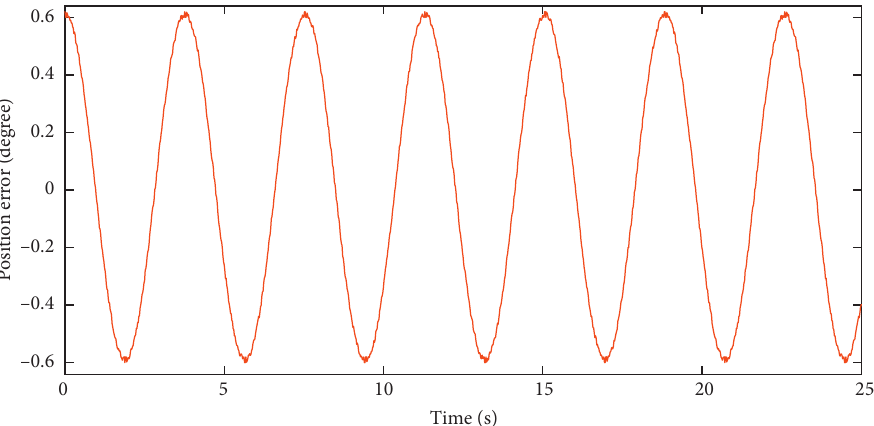
Figure 14: Position tracking error